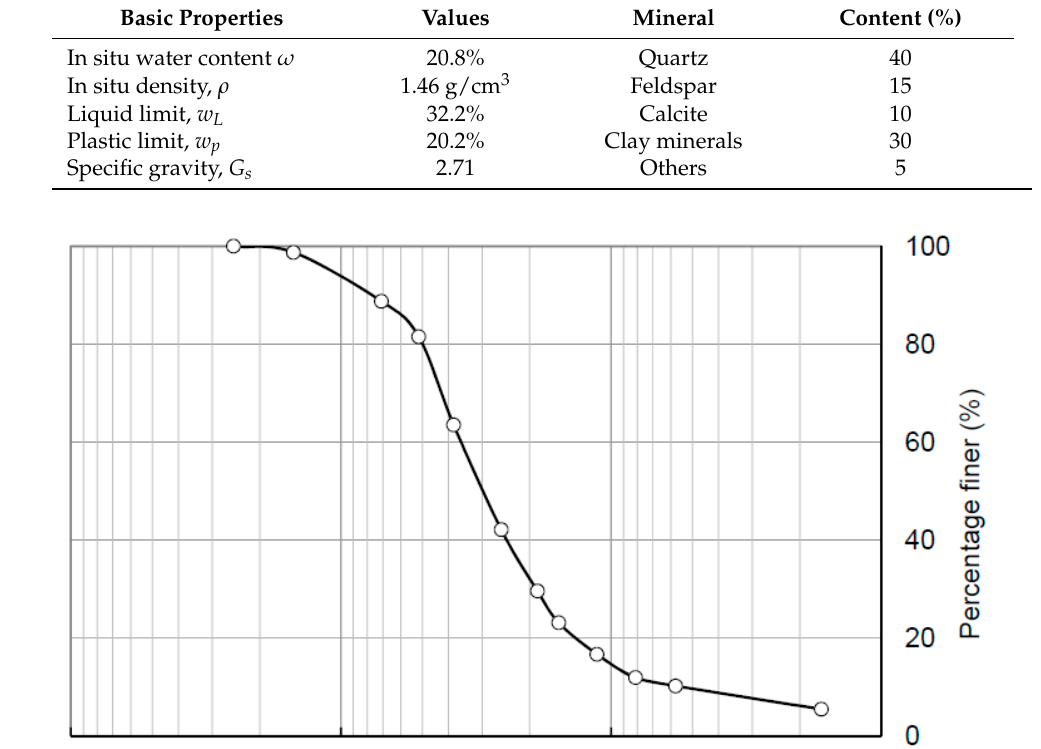
Table 2. Initial parameters of tested loess specimens.